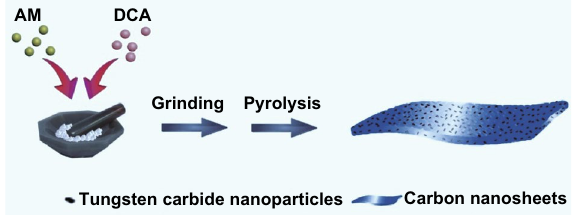
Fig. 1 Schematic illustration for solvent-free synthesis of different tungsten carbide/carbon